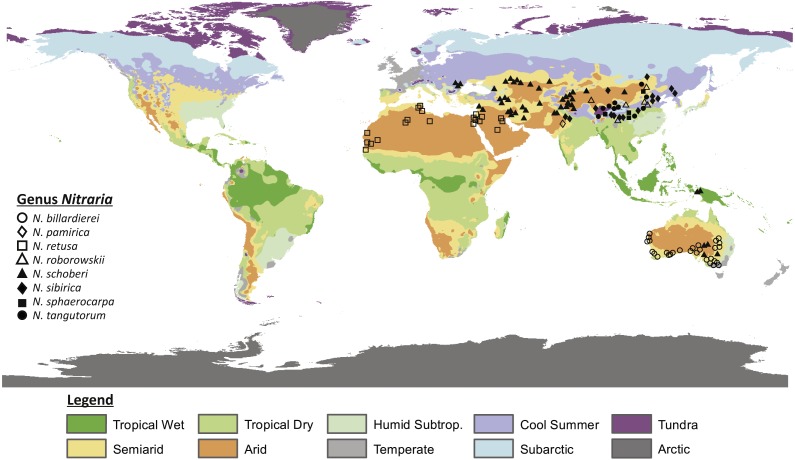
Map showing the present distribution of the genus Nitraria.The climate map was modified after Peel, Finlayson & McMahon (2007). Coordinates of the occurrences obtained from GBIF and Tropicos can be found in Appendix S1.